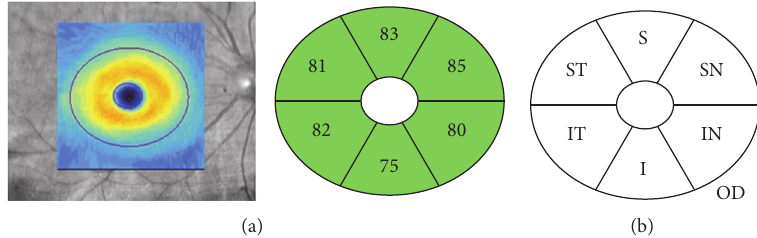
Figure 3: An example (a) and a schematic diagram (b) of an optical coherence tomography scan of the macular ganglion cell-inner plexiform layer, showing the area of the macula with a 4.0-mm-long × 4.8-mm-wide oval shape (excluding a 1.0-mm × 1.2-mm ellipse), centered on the fovea of the right eye. ST, superotemporal; S, superior; SN, superonasal; IN, inferonasal; I, inferior; IT, inferotemporal; OD, right eye.